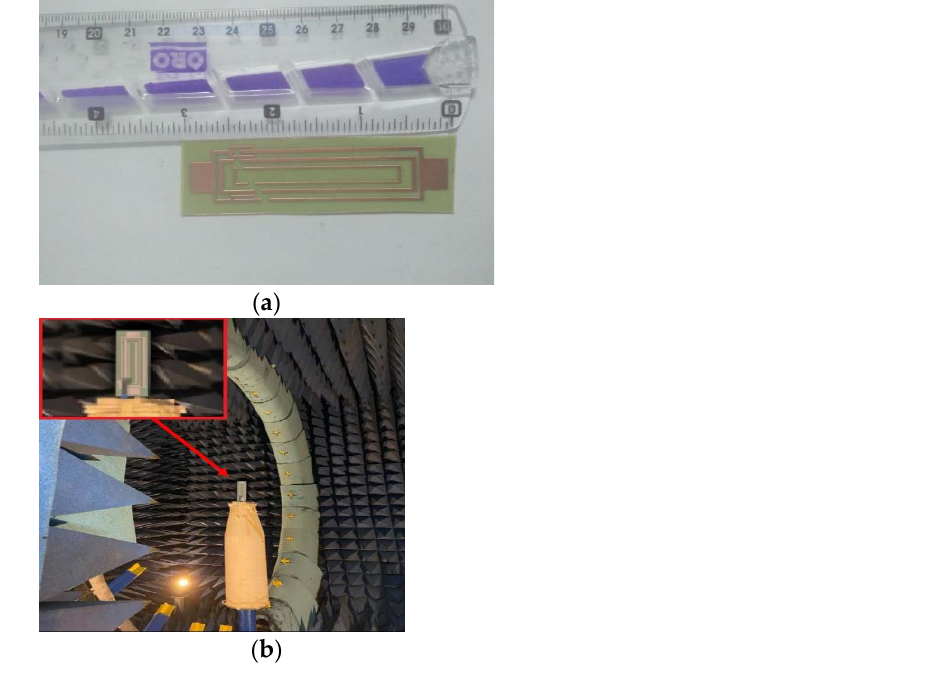
( b ) Figure 18. Radiation of proposed RFID antenna. ( a ) At 837 MHz. ( b ) At 927 MHz. Simulations and experimental results indicate that proposed antenna performances are very promising since they have an important long read-range of 25 m, by using Mping M730 chip with − 24 dB sensitivity [16], and an omnidirectional radiation pattern at both